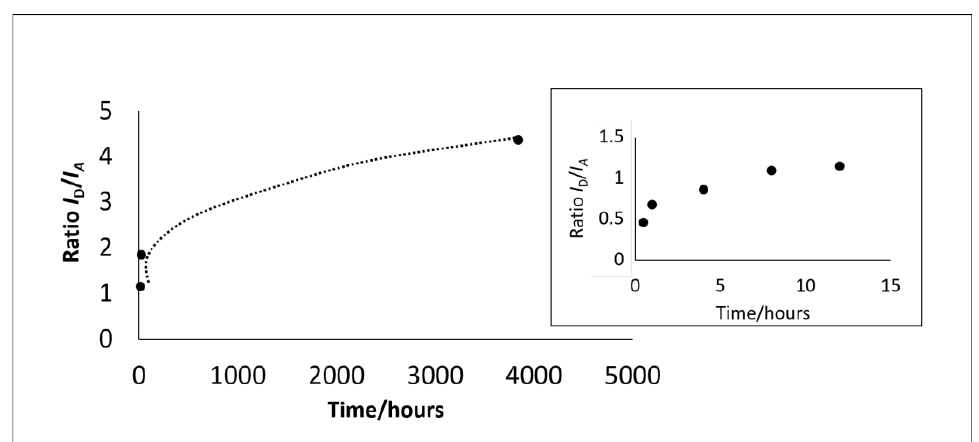
Figure 9. Diagram of the ratio of intensities of IR bands of calcium carbonate and calcium hydroxide ( I D / I A ) versus time. Insert shows in detail the 0–16 h interval.